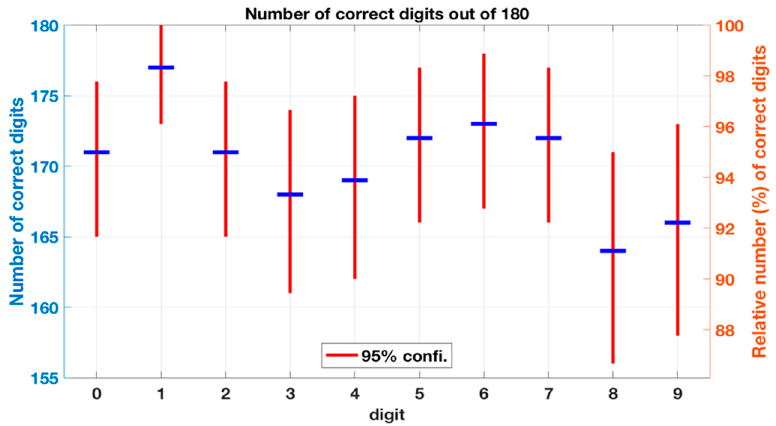
Figure 8. Number of correct digits for each user.